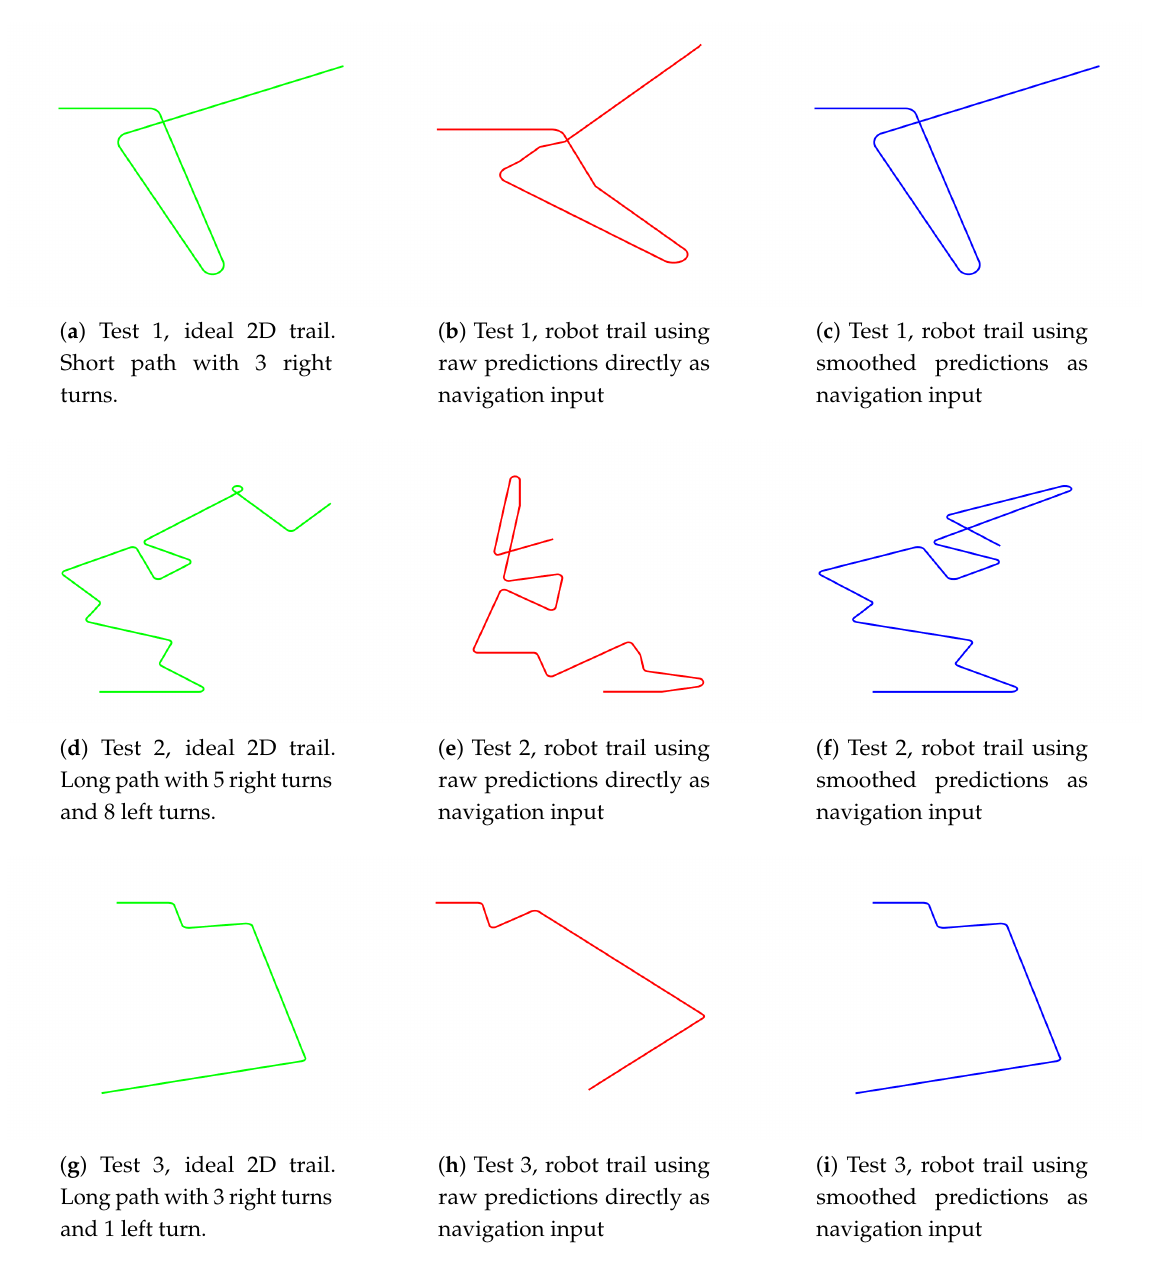
Figure 12. Robot navigation 2D trails in 3 separate tests. ( a , d , g ) are manually selected ideal drive trails; ( b , e , h ) are trails with raw network predictions as navigation inputs; ( c , f , i ) are trails with smoothed network predictions as navigation